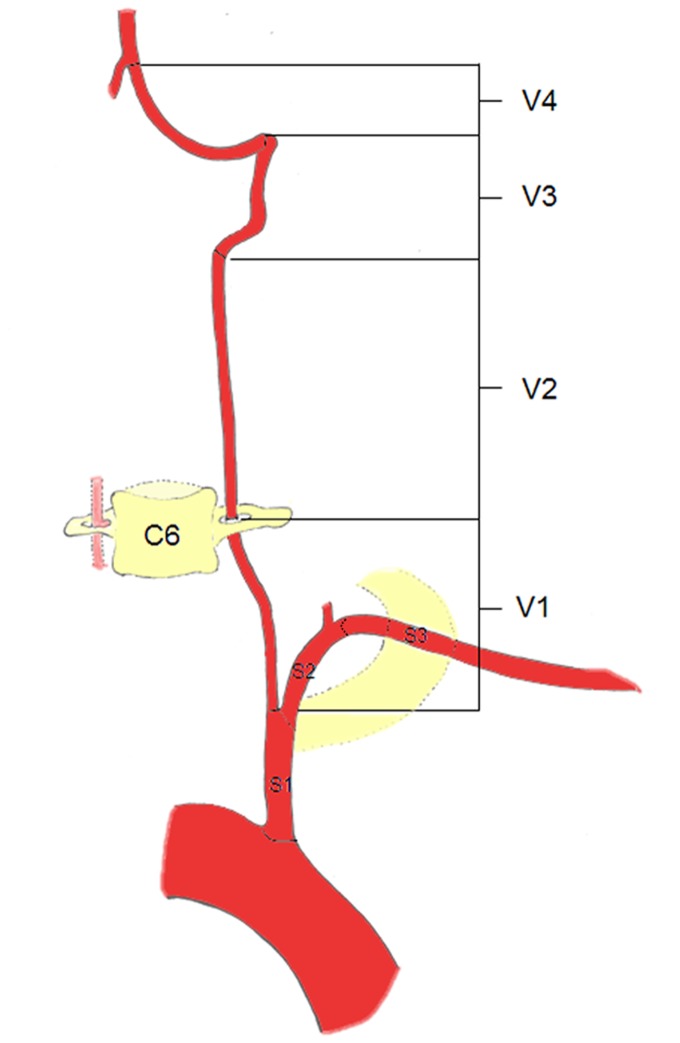
Schematic diagram illustrating the segments of the vertebral artery (VA) and subclavian artery (SA).V1 begins from the origin of VA to where it enters the transverse foramina at the fifth or sixth cervical vertebra. V2 begins from the level of the fifth or sixth cervical to the second cervical vertebra travelling through the transverse foramina at each vertebral level. V3 extends between the C2 transverse process and ends at the base of the skull where it enters the foramen magnum. V4 extends from the point at which the arteries enter the dura to the termination of both VAs at the vertebrobasilar junction. S1 begins the origin of SA and ends just proximal to the origin of SA. S2 begins just proximal to the origin of SA and ends the medial border of the scalenus anterior. S3 extends from the medial border of scalenus anterior to the outer border of the first rib.